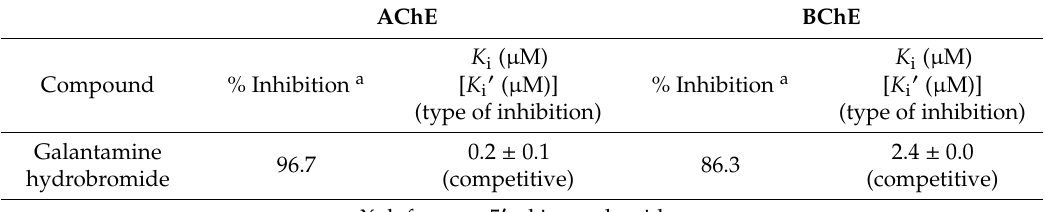
AChE BChE K i ( µ M) K i ( µ M) [ K i (cid:48) ( µ M)] % Inhibition a [ K i (cid:48) ( µ M)] (type of inhibition) (type of inhibition) 2.4 ± 0.0 0.2 ± 0.1 86.3 96.7 (competitive) (competitive) Xylofuranos-5 (cid:48) -yl isonucleosides Purine derivatives